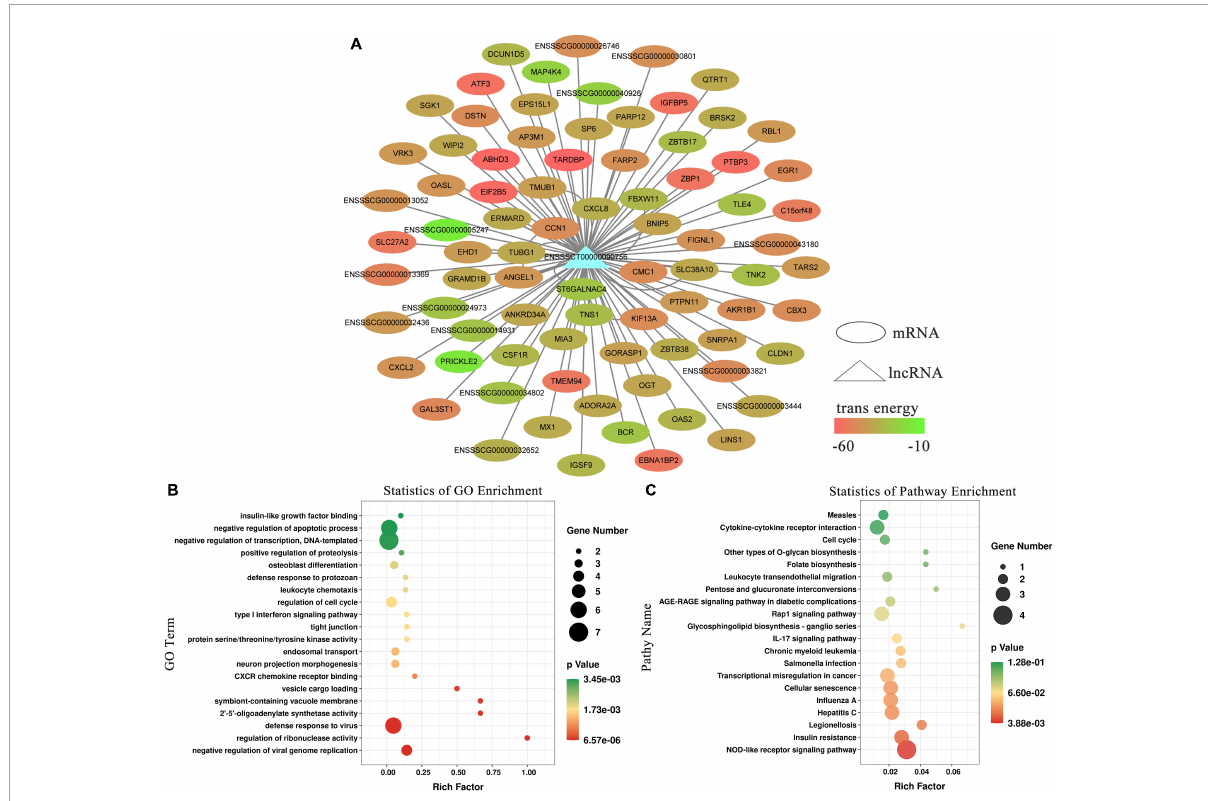
FIGURE2 Functional enrichment analysis of long non-coding RNA (lncRNA) EN-90756 . (A) Network between lncRNA EN-90756 and differentially expressed mRNAs. The ellipse represents mRNAs, the triangle represents the lncRNA, and the color of the ellipse represents the formation of secondary structure free energy between the lncRNA and mRNA sequences. Functional enrichment analysis of lncRNA EN-90756 significantly differentially expressed target genes. (B) The top 20 significant gene ontology (GO) enrichment terms. (C) The top 20 enriched Kyoto Encyclopedia of Genes and Genomes (KEGG) pathways. In the scatter plot, the size of the dots represents the number of genes with significant differences, and the color of the dots represents the significance of the enrichment ( p